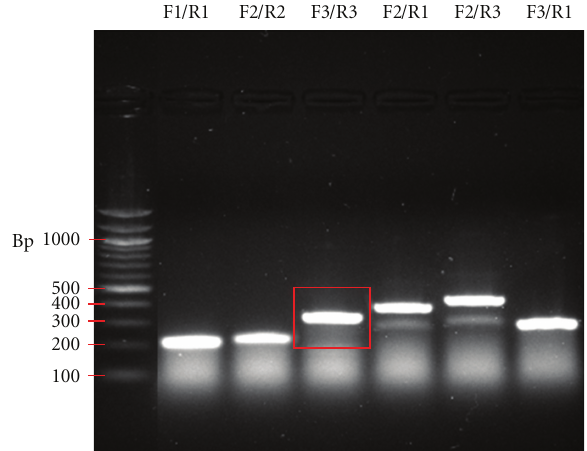
Figure 3: F3/R3 product. RT-PCR products (Invitrogen MMLV-RT, GoTaq Green Polymerase). Several reactions successfully produced robust bands at the predicted sizes: 200 and 209 nucleotides for F1/R1 and F2/R2, respectively, and 311 nucleotides for F3/R3. Since the product of primer pair F3/R3 (outlined in a red box) encom- passed all 6 possible editing sites, this RT-PCR band product was extracted for sequencing (100bp ladder, New England Biolabs, Ipswich,